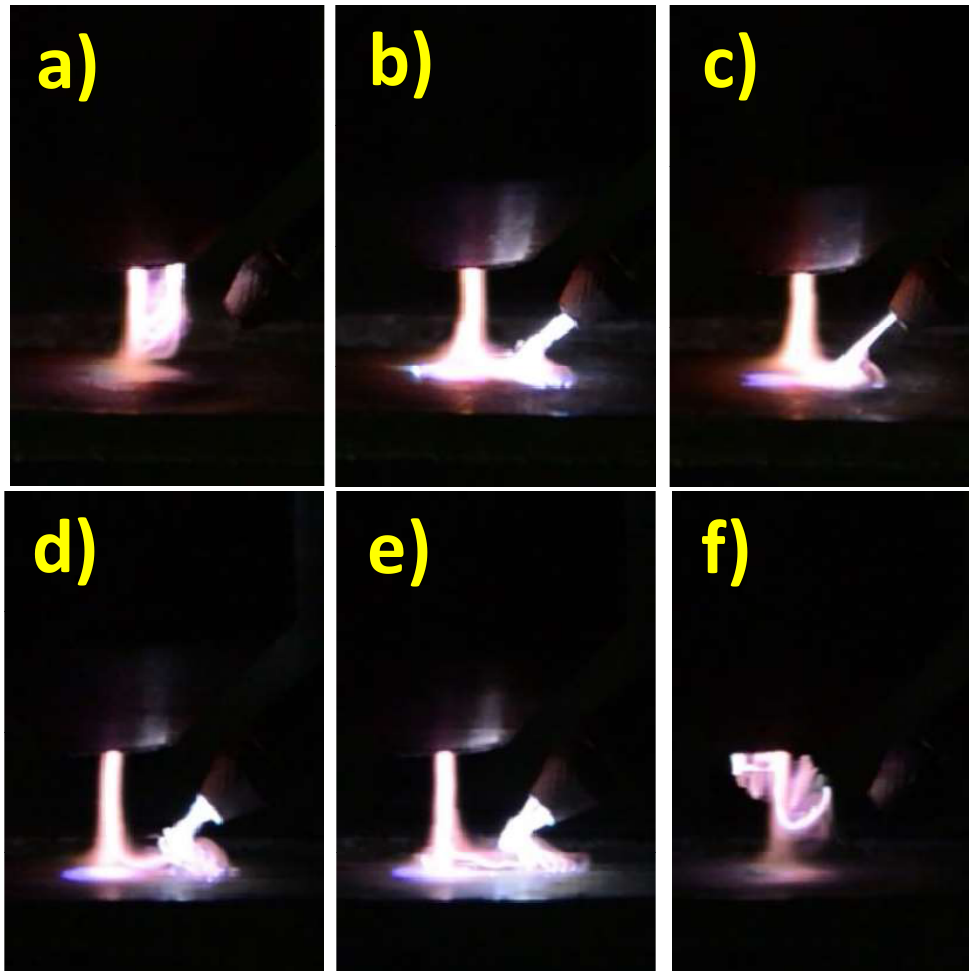
Figure 11. Pictures of ignition ( a – c ) and extinction ( d – f ) of the plasma bridge initiated by the start and stop of the argon flow, respectively. Argon flow: 5 SLM, FG 95/5 flow: 60 SLM, power level: 100%, frequency: 62 kHz, distance between the nozzle and the substrate: 6.5